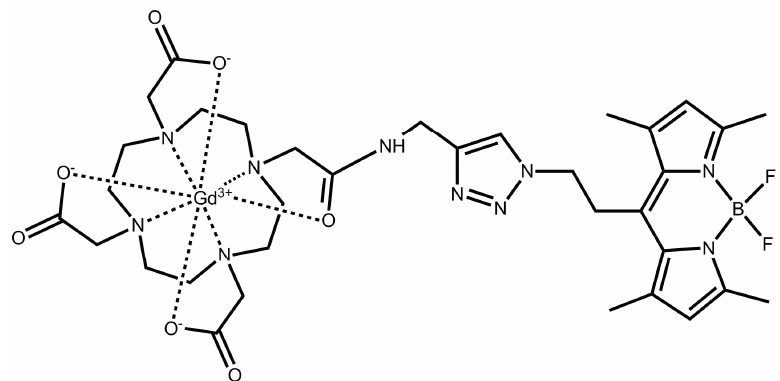
Figure 1. The Gd-DOTA-BODIPY